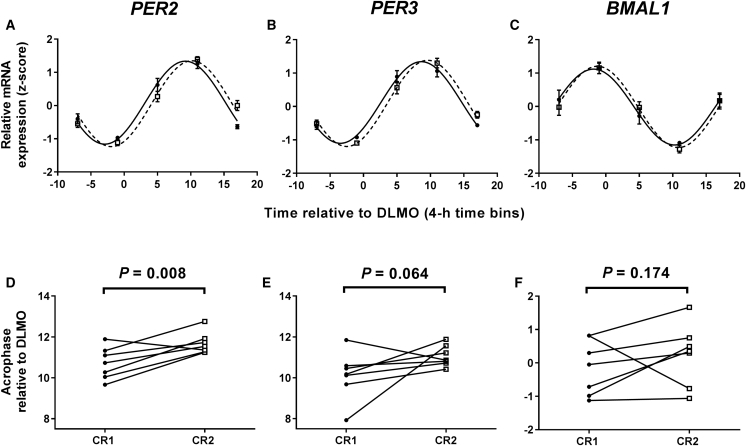
A 5-hr Delay in Meal Times Delays Clock Gene Rhythms in White Adipose Tissue(A–C) Temporal expression profiles of PER2 (A), PER3 (B), and BMAL1(C) in 6-hourly white adipose tissue biopsies collected in constant routine conditions. Data are plotted as mean ± SEM. Black circles with solid lines represent data following early meals (0.5, 5.5, and 10.5 hr after waking up). White squares with dashed lines represent data following a 5-hr delay in each meal. Two-way repeated-measures ANOVA revealed a significant effect of time for PER2 (F(4,24) = 56.81, p < 0.001), PER3 (F(4,24) = 65.67, p < 0.001), and BMAL1 (F(4,24) = 21.44, p < 0.001). There was no overall effect of meal for any gene: PER2 (F(1,6) = 1.00, p = 0.356), PER3 (F(1,6) = 1.07, p = 0.340), and BMAL1 (F(1,6) = 1.08, p = 0.339). There was a significant meal × time interaction for PER2 (F(4,24) = 7.31, p < 0.001), but not for PER3 (F(4,24) = 2.44, p = 0.075) or BMAL1 (F(4,24) = 0.58, p = 0.680).(D–F) Acrophase of PER2 (D), PER3 (E), and BMAL1 (F) rhythms in individuals following early meals (CR1; black circles) and following a 5-hr delay in meal time (CR2; white squares). Using a paired t test, there was a significant effect of meal timing on PER2 phase (delay of 0.97 ± 0.29 hr; t(6) = 3.35, p = 0.008), but not on the phase of PER3 (t(6) = 1.77, p = 0.064) or BMAL1 (t(6) = 1.02, p = 0.174).(A–F) Data are from n = 7 participants, calculated relative to each individual’s DLMO. Statistical significance is defined as p < 0.017 (following Bonferroni correction for analysis of a total of three rhythmic adipose markers).See also Figure S3.